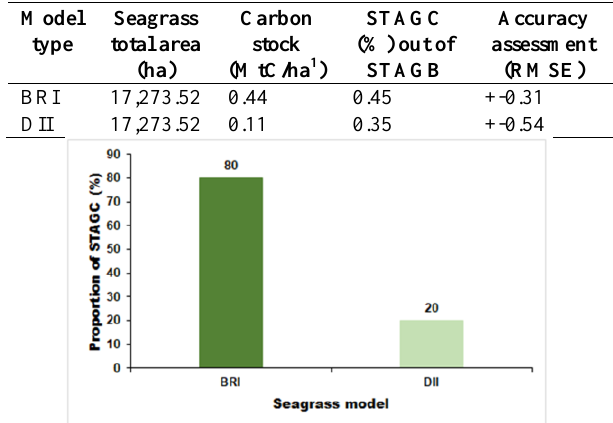
Table 5. The proportion of STAGC of both western and eastern Johor.